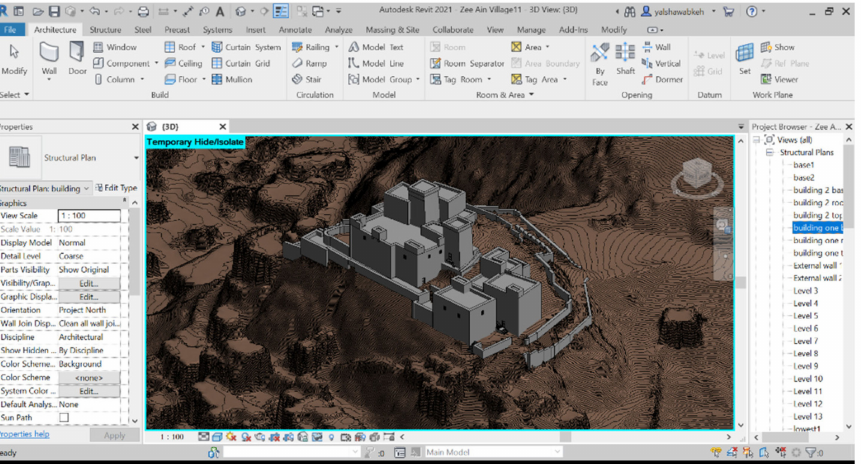
Figure 19. HBIM modeling of the buildings’ geometry with the surrounding terrain.